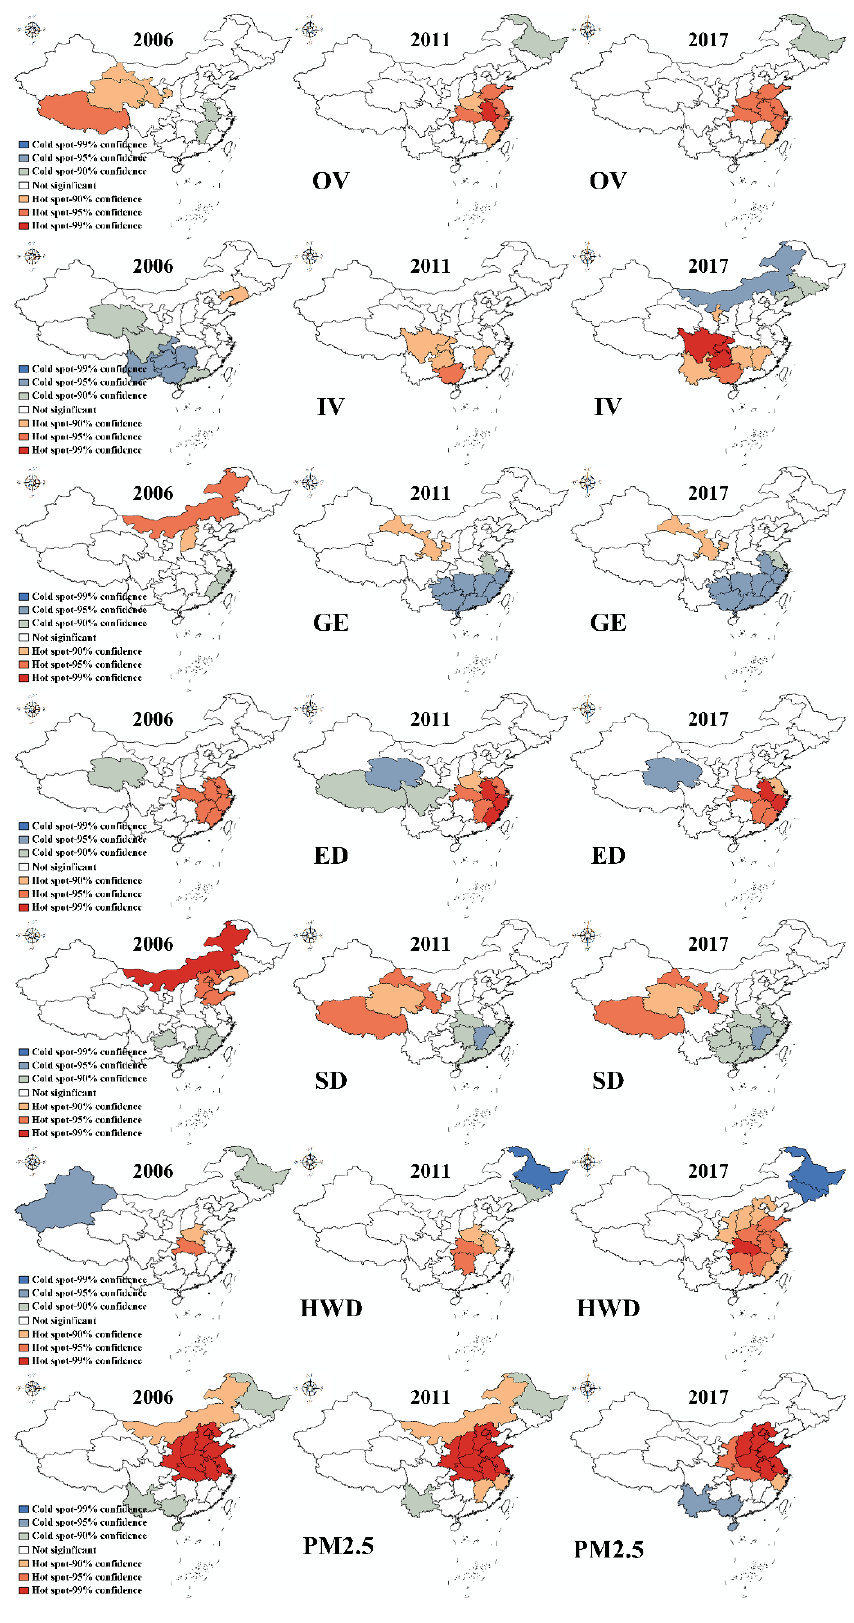
Figure 4. Hot spot analyses 1 . 1 OV: outpatient visits per capita; IV: inpatient visits per capital; ED: effluent discharge; GE: gas emission; SD: solid discharge; PM2.5: average PM2.5 concentration; HWD: household waste disposal.